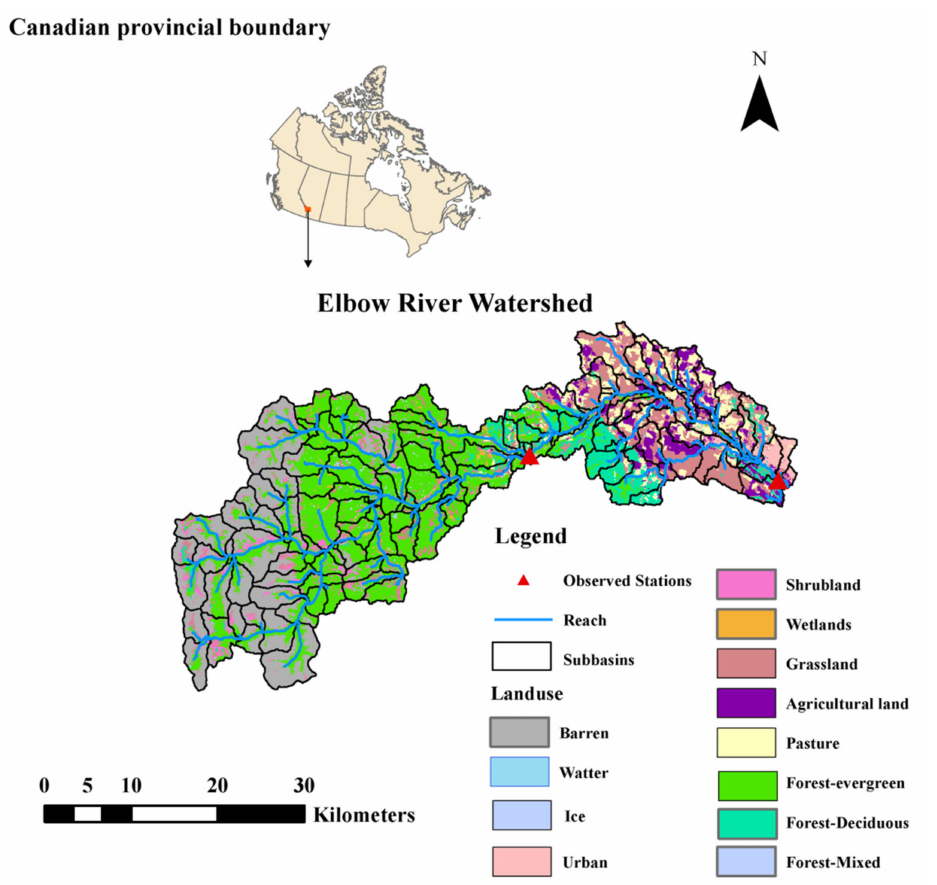
Figure 1. Geographic location of Elbow River watershed in southern Alberta, Canada. The map illustrates spatial distribution of di ff erent land use types and the two hydrometric stations used for calibration analysis in this